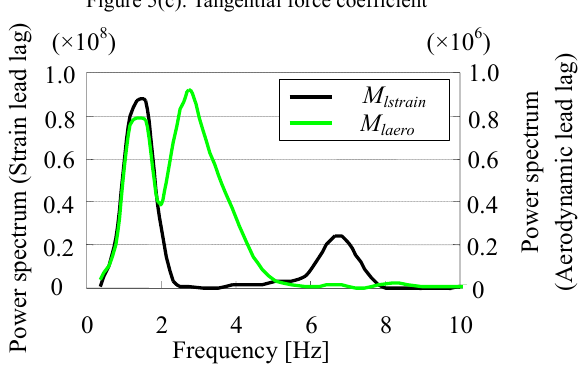
Figure 5(c). Tangential force coefficient